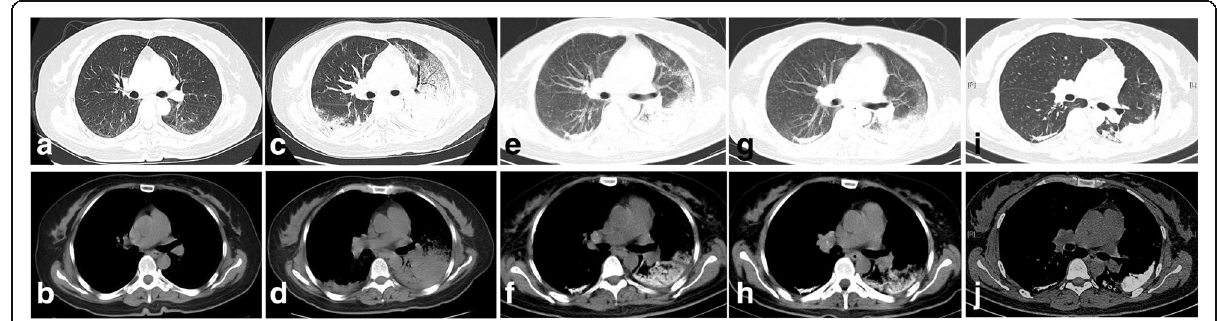
Fig. 2 CT scanning of the chest. a , b Initial CT scans: A little linear opacity on the bilateral pulmonary. c , d CT scans five days later: Bilateral pulmonary multiple high-density shadow with mass consolidation and exudation; obvious progression when compared with initial scan. e , f Chest image after treatment of two weeks: Obvious calcification in bilateral lungs. g , h Chest CT after left parathyroidectomy: Lesions were mildly improved. i , j Pulmonary calcifications did not deteriorate or improve 8 months later in the follow-up